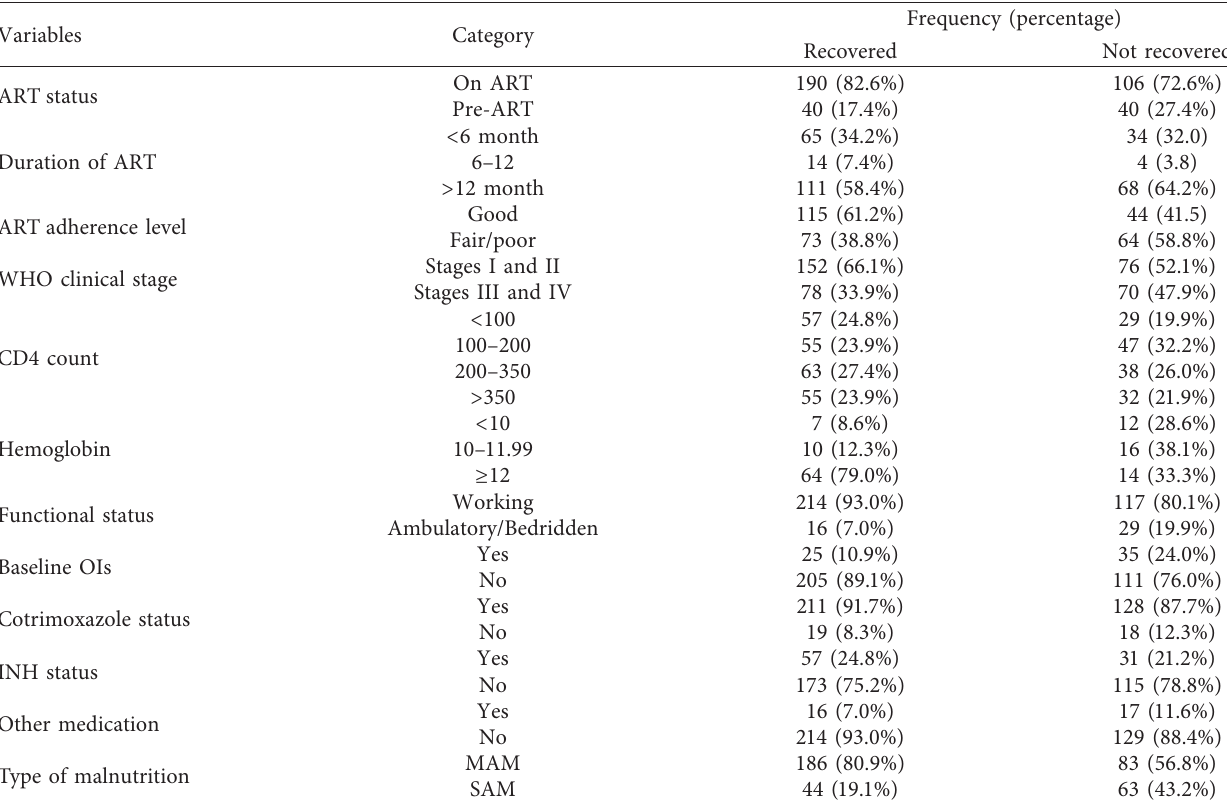
Table 2: Baseline and follow-up clinical characteristics of adult malnourished HIV patients enrolled in the therapeutic feeding program, Finote-Selam Hospital, Northwest Ethiopia, 2010–2017.